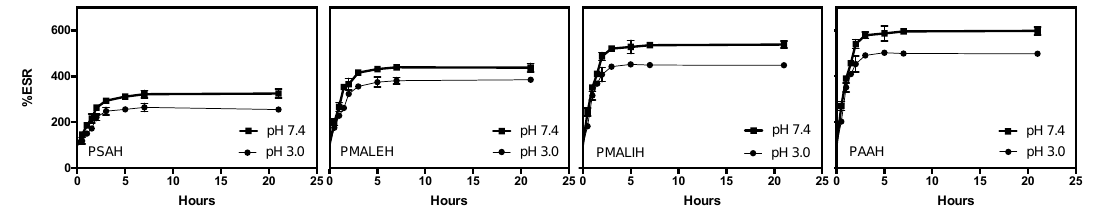
Figure 2. The swelling ratio of the PDCAH at 24 °C as a function of time, pH and crosslinker nature. Data are shown as mean ± SD ( n = 3).